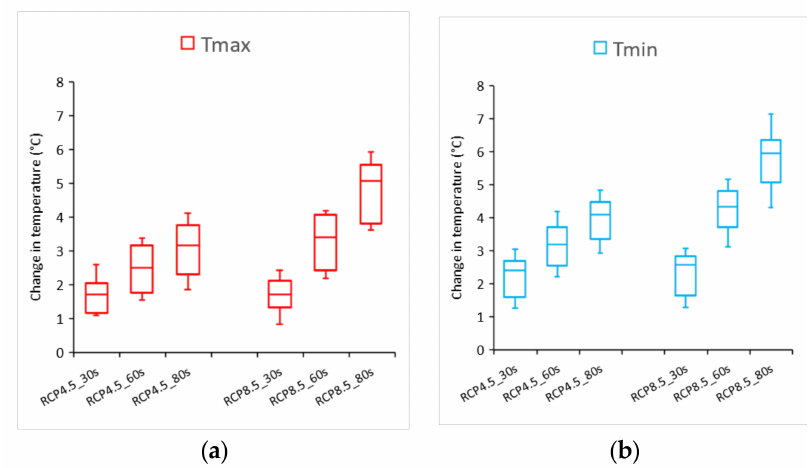
Figure 6. Absolute changes in monthly mean ( a ) maximum and ( b ) minimum temperatures in the Bheri River Basin under the two RCP scenarios for the 30 s, 60 s, and 80 s periods, relative to the baseline (1975–2005).